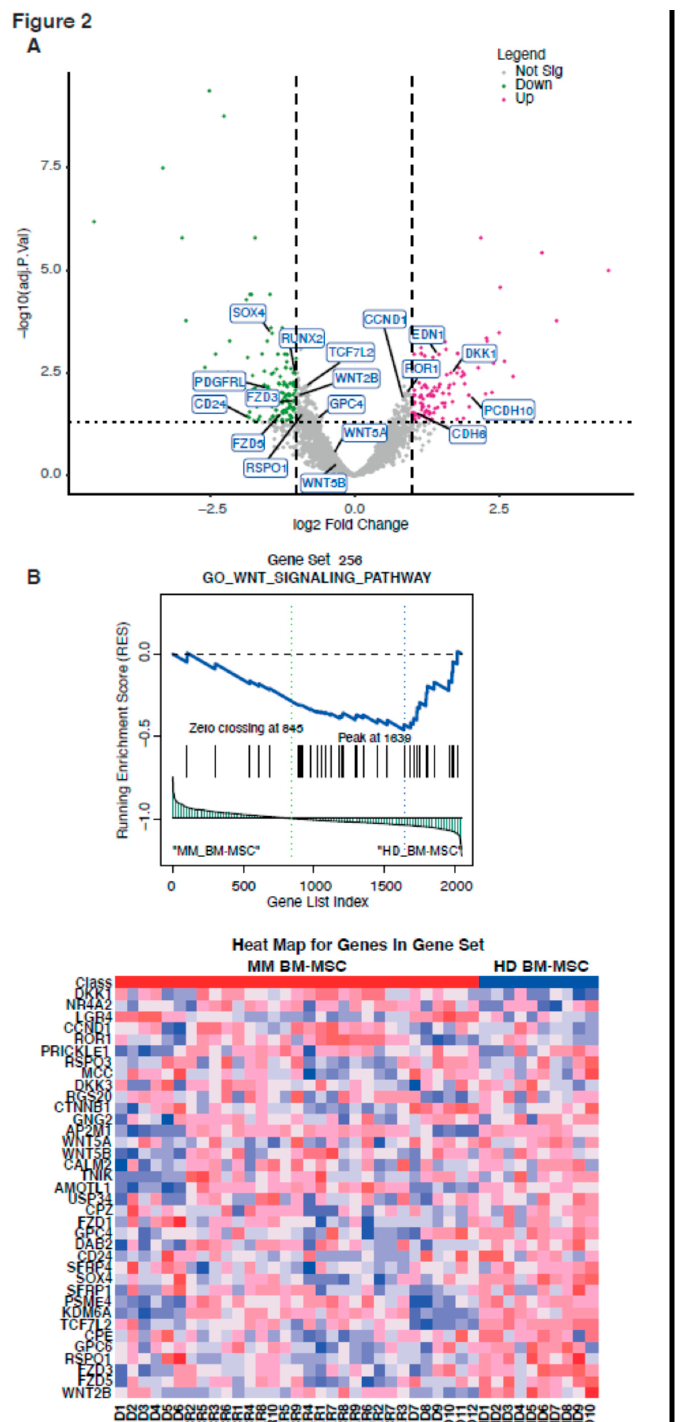
Figure 2. Wnt pathways involved in the difference between MM BM-MSC and HD BM-MSC. Volcano plot of differentially expressed genes in MM vs. HD BM-MSC with the impact of genes on osteogenesis and the Wnt pathway ( A ). Representative Gene Set Enrichment Analysis (GSEA) of the MM vs. HD BM-MSC list of expressed genes with the pathway of Gene Set 256 (GO Wnt signaling pathway). Wnt signaling pathway was downregulated by MM vs. HD BM-MSC. The corresponding heatmap of the represented genes is also shown ( B ).